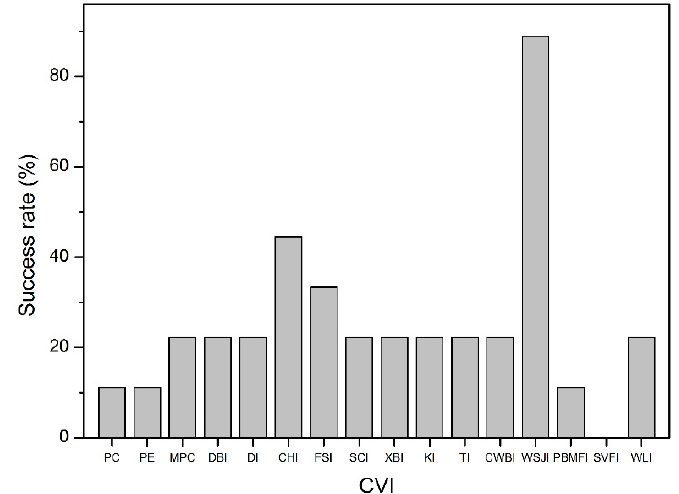
Figure 5. The overall performance of CVIs by applying FCM algorithm to cluster nine types of remote sensing datasets. Table 12. The optimal cluster numbers indicated by the CVIs by FCM for each remote sensing image. Images